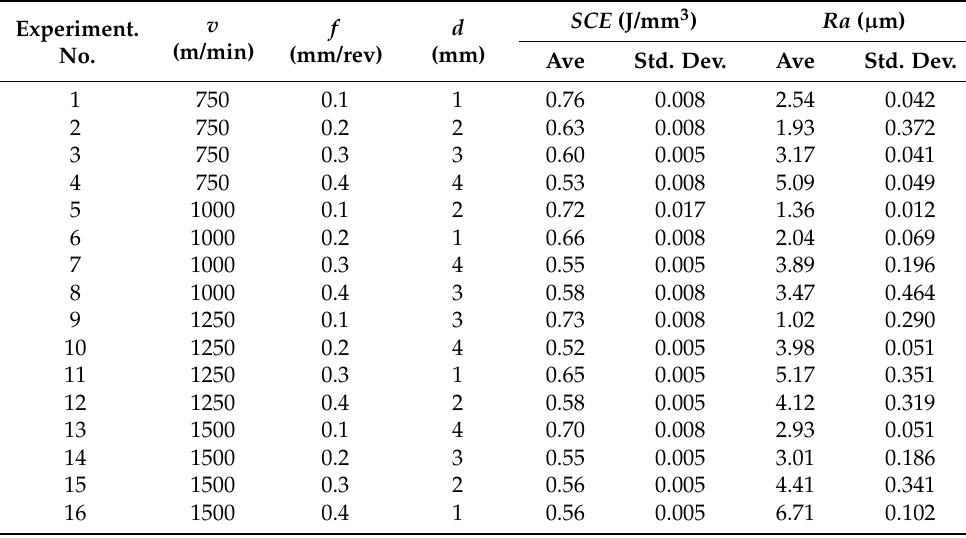
Table 8. Results of L 16 experimental plan for transitional speed machining range. Experiment.